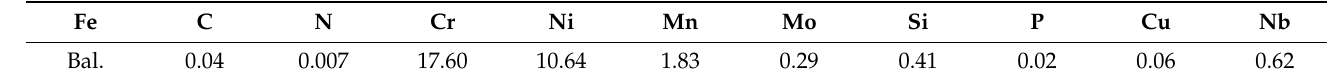
Table 4. Chemical composition of AISI 347 in wt%.